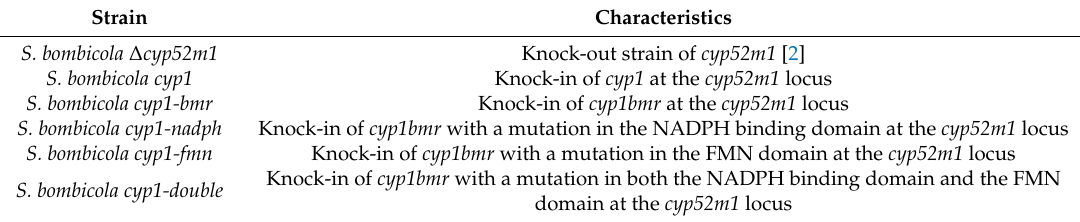
Table 2. Strains used and created during the research. NADPH—reduced nicotinamide adenine dinucleotide phosphate; FMN—flavin